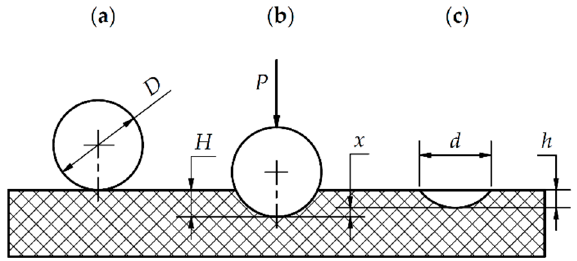
Figure 4. The imprint creation during hardness tests: ( a )—stage 1, the ball without load, ( b )—stage 2, the ball loaded with measuring force, ( c )—stage 3, the permanent indentation after a force is re- moved ( P —measuring force, D —diameter of the ball, d —the permanent imprint diameter, H —the total imprint depth, h —the permanent (plastic) imprint depth, x —the elastic (temporary) component of imprint depth).